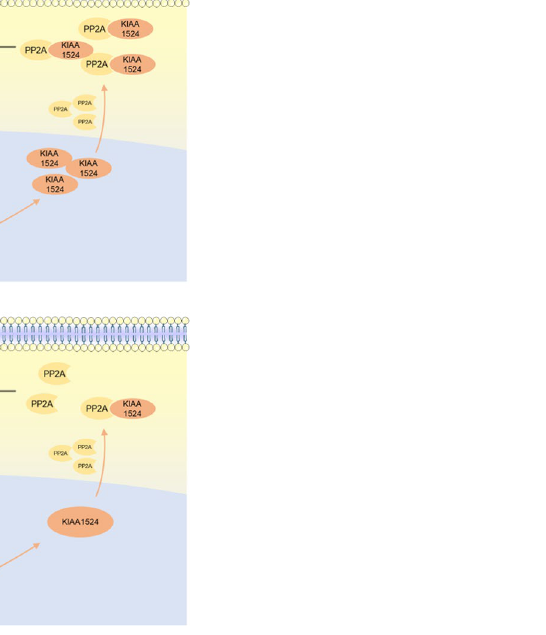
Figure 7. summarized signal pathway diagram of